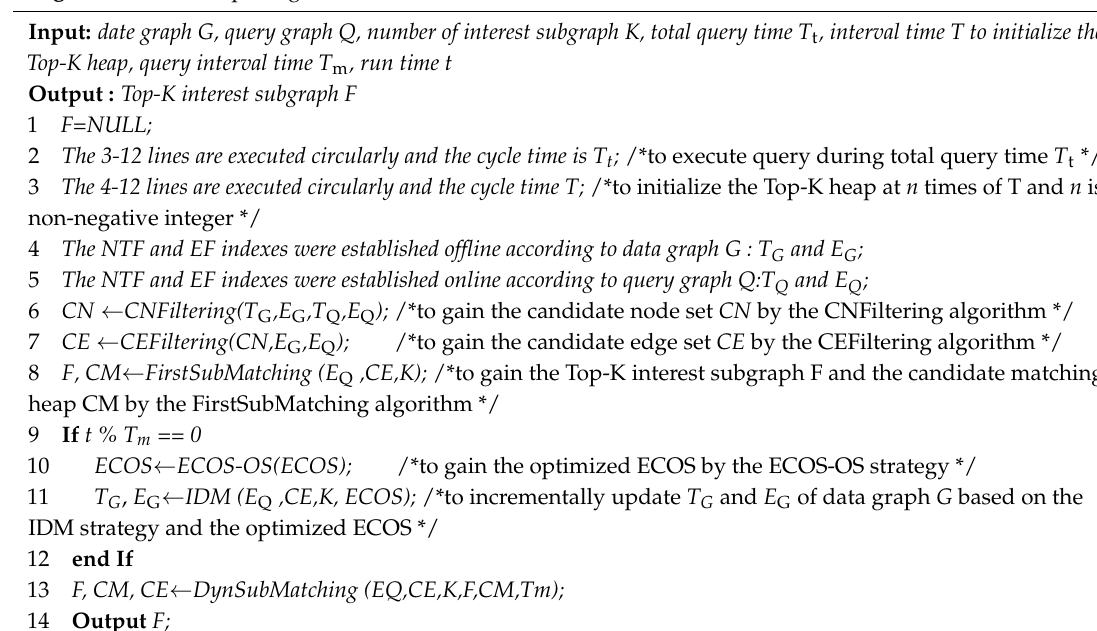
Algorithm 4 DISQtop-k